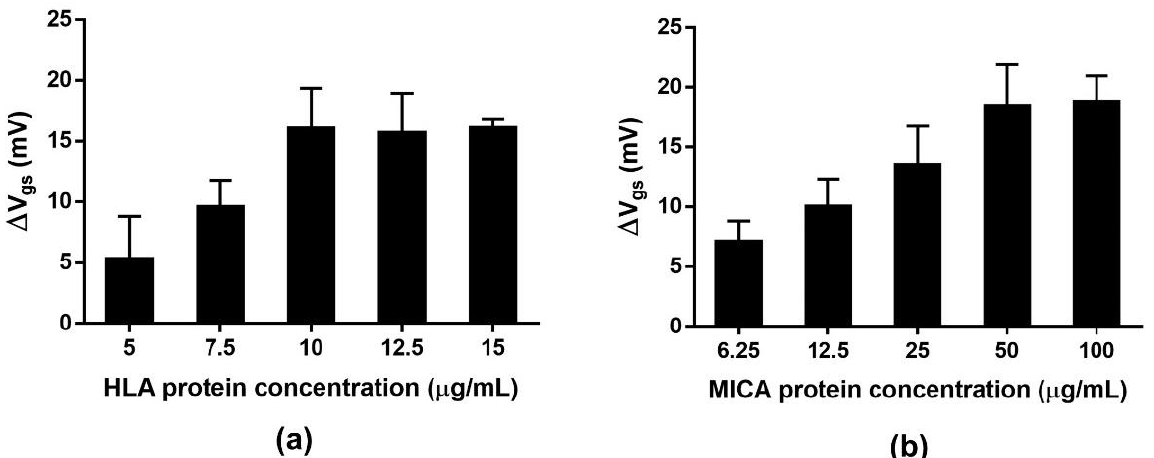
Figure 7. Optimization of HLA and MICA protein immobilization for electrical measurement. ( a ) The ΔV gs obtained various concentrations of HLA protein immobilization. ( b ) The ΔV gs was ob- tained from various concentrations of MICA protein immobilization.